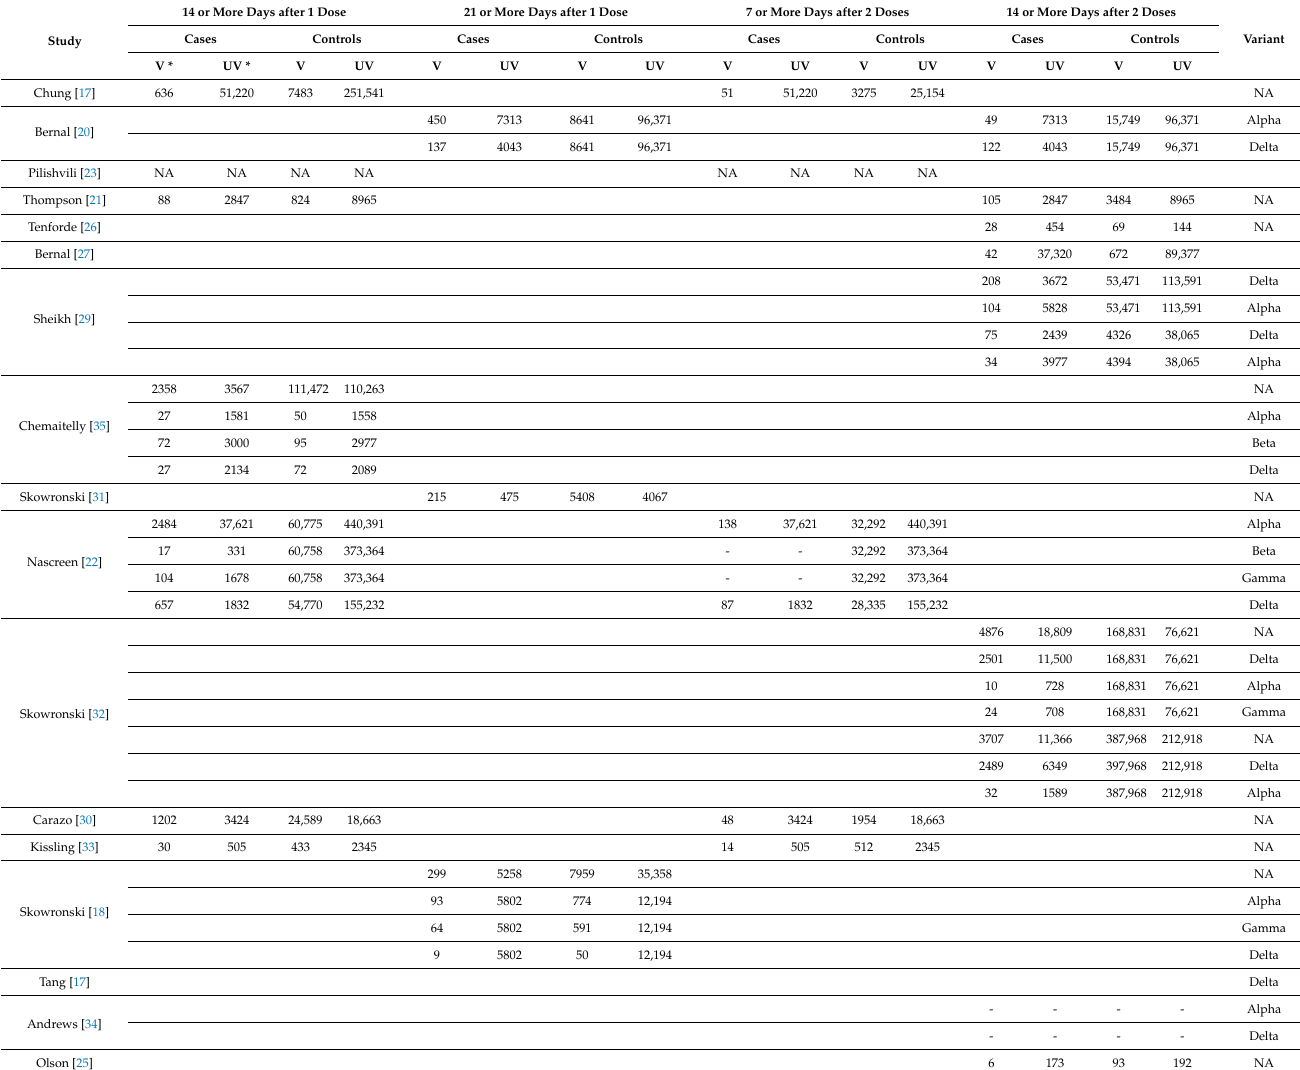
Table A1. Characteristics of BNT162b2 vaccine vaccinated participants.